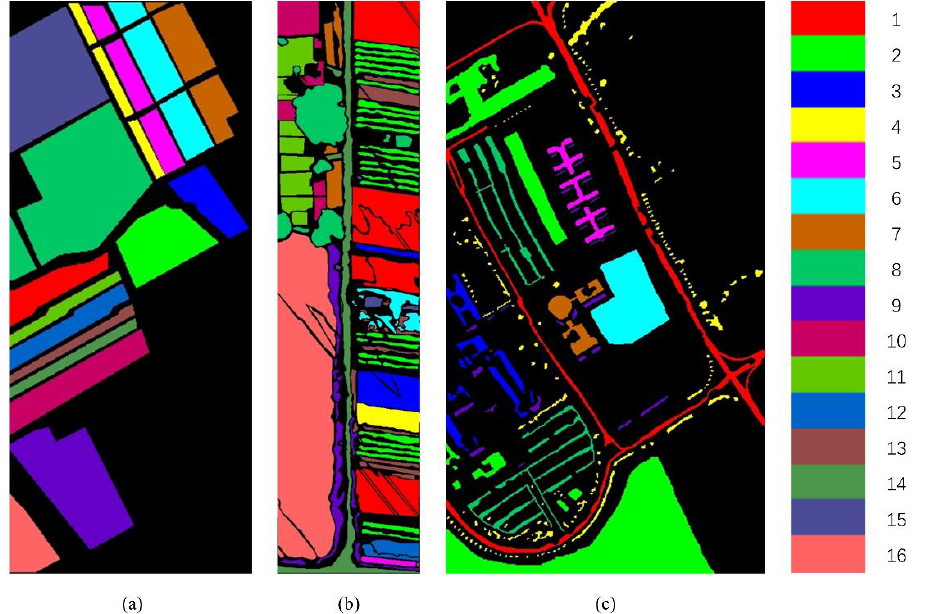
Figure 3. Ground truth of the three datasets: ( a ) SA; ( b ) WHU; ( c ) PU. It should be noted that the category number of the datasets denoted by the color bar on the right represents the same category number as Tables 1 – 3.